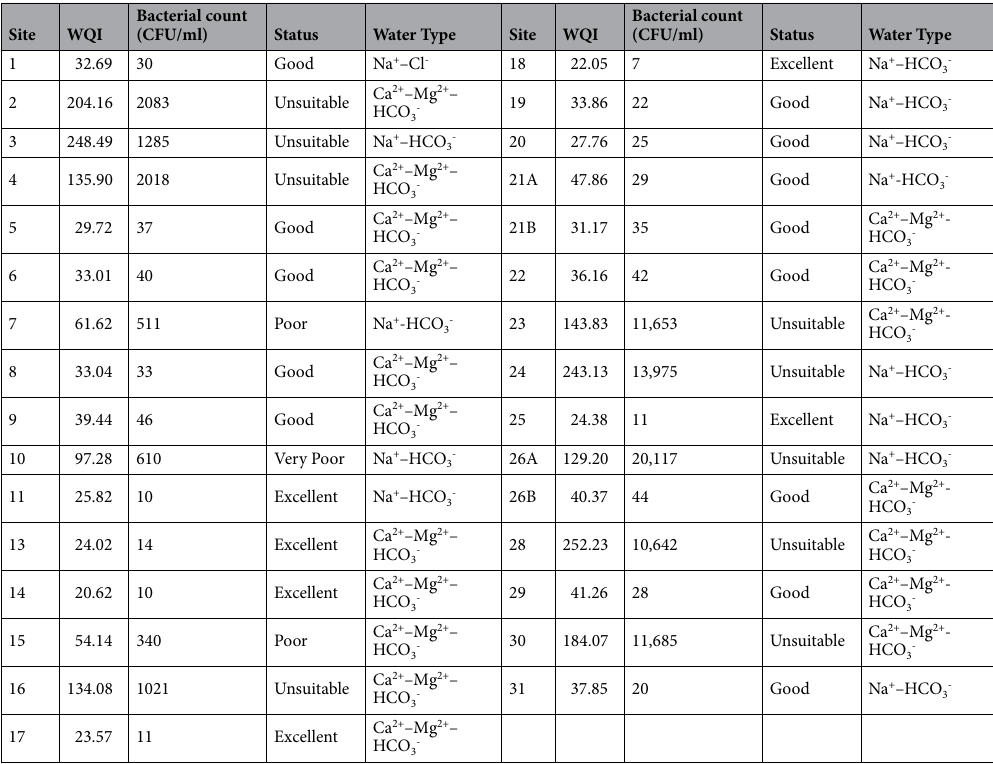
Table 7. WQI, bacterial count (CFU/ml) and water type of Tawang samples collected from different sites.